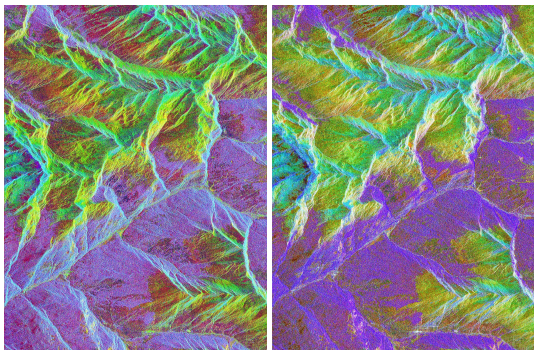
Figure 8. Examples of visualization results by CAE (left) or PCA (right) obtained by permutation on the order of the Red, Green, and Blue color